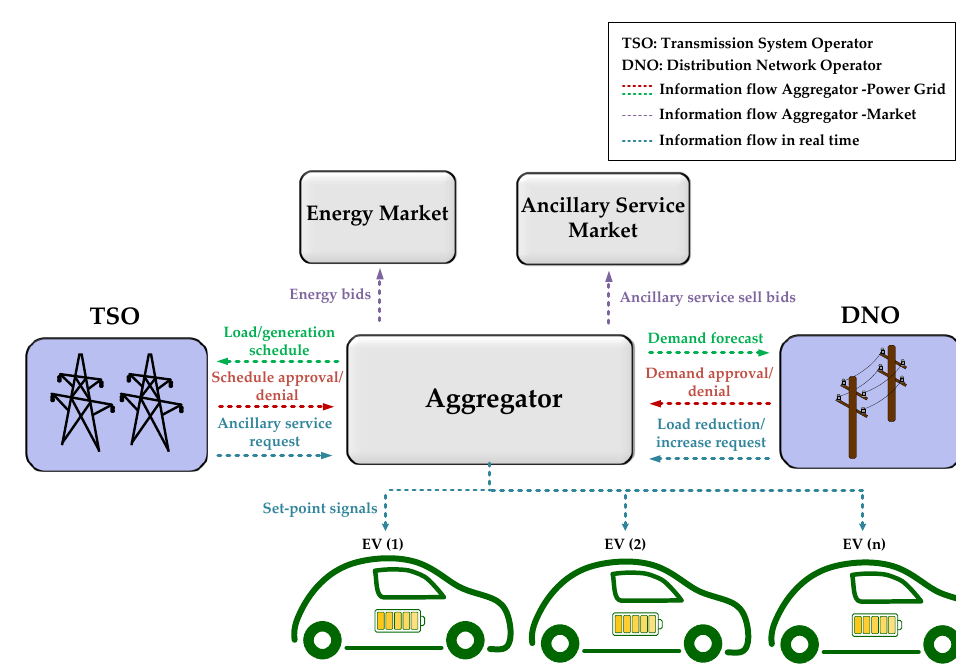
Figure 8 . Centralized control architecture of EV charging [15]. Figure 8. Centralized control architecture of EV charging [15].